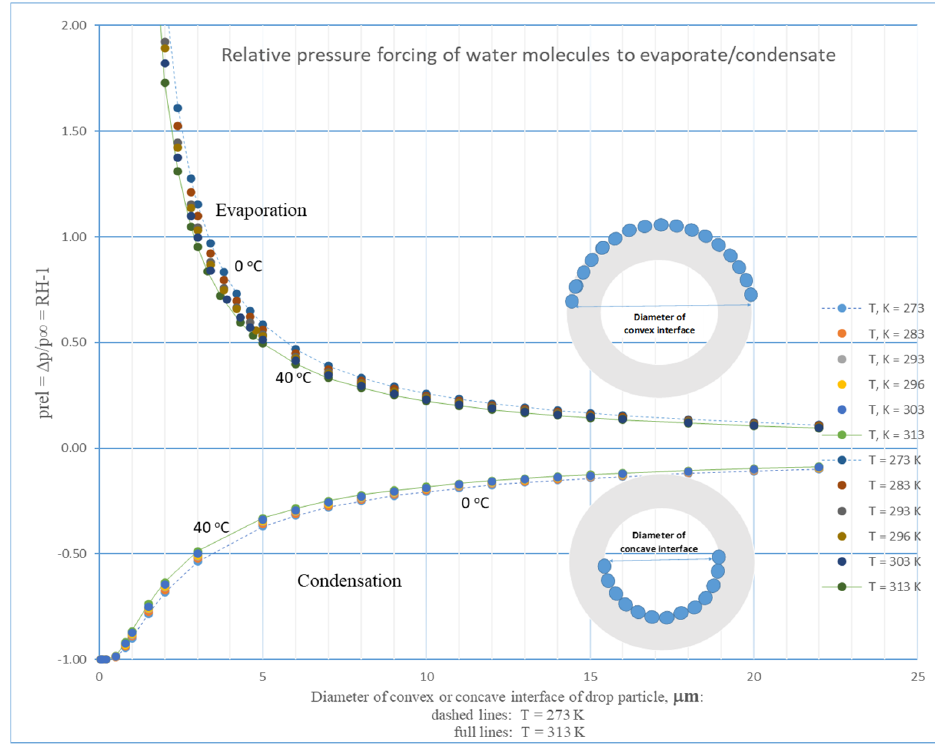
Figure 11. Relative pressure, p rel forcing water molecules to evaporate (convex interface) or conden- sate (concave interface) vs. diameter of droplets with water shells at constant temperature.